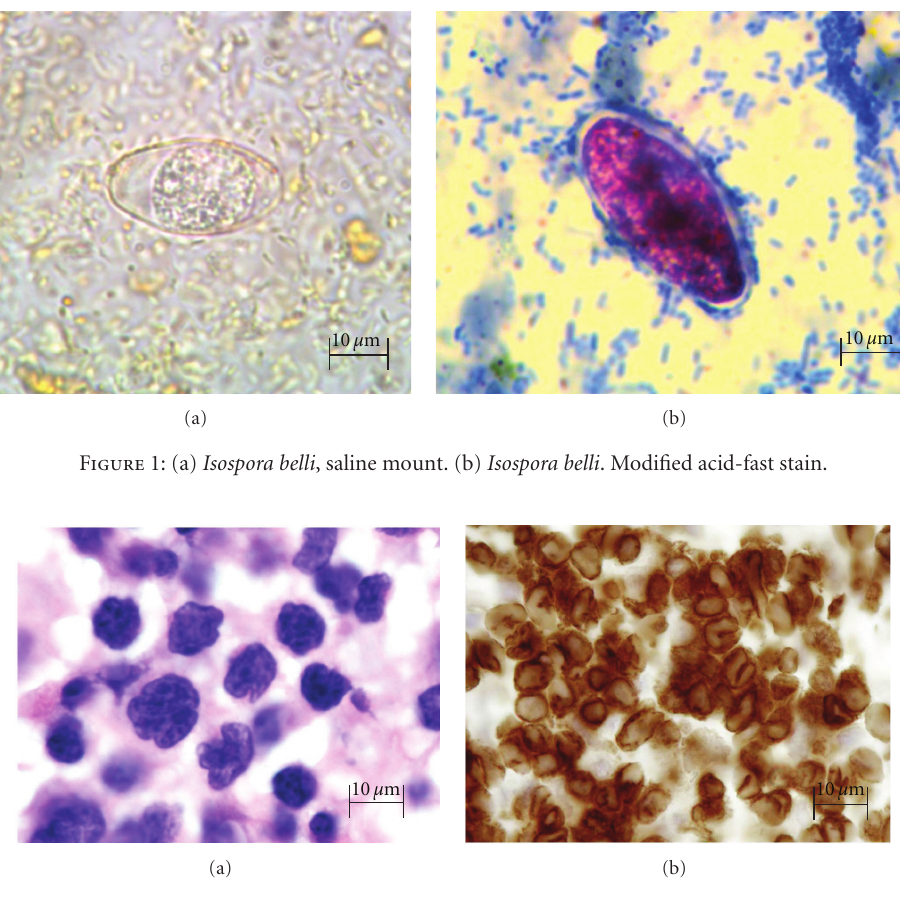
Figure 2: (a) Right femur shavings showing aggregates of small-to-medium-sized lymphoid cells with irregular to convoluted nuclei, with admixed large cells and eosinophils. Hematoxylin and eosin. (b) Immunohistochemical stains showing T-cell phenotype.